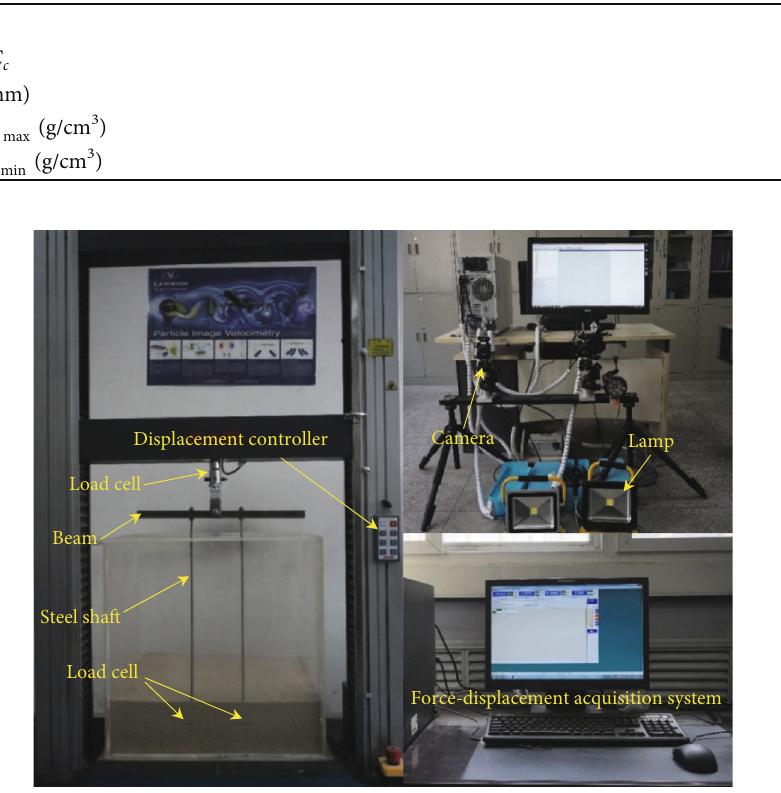
Figure 1: Experimental